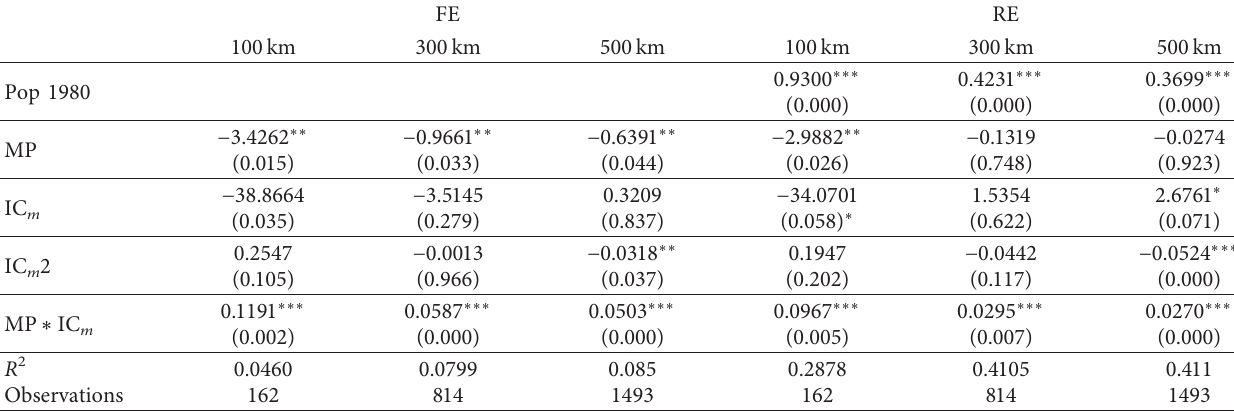
Table 6: Regression results of manufacturing share within 100 km, 300km, and 500km, 5-year